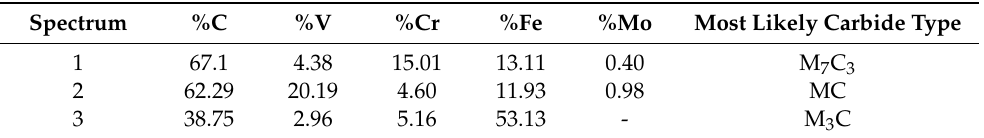
Table 4. Analysis of the phases listed in Figure 2, determined by the characteristic energy dispersive X-ray (EDX) microanalysis. Results are presented in atomic %.